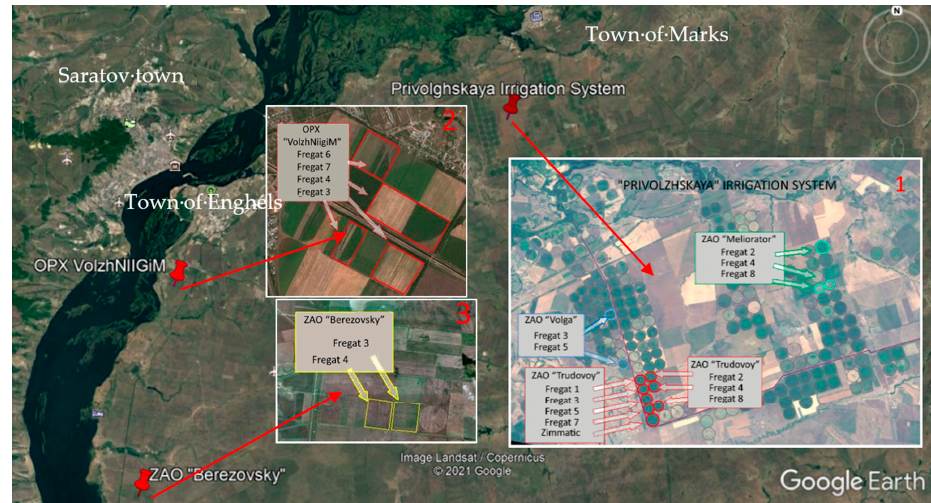
Figure 1. Three study sites belonging to the territories of: (1) Privolzhskaya Irrigation System; (2) Experimental farm of the All-Russian Scientific Research Institute of Hydraulic Engineering and Land Reclamation (VolgNIIGiM); (3) “Berezovsky” agricultural farm (copied from Google Earth).